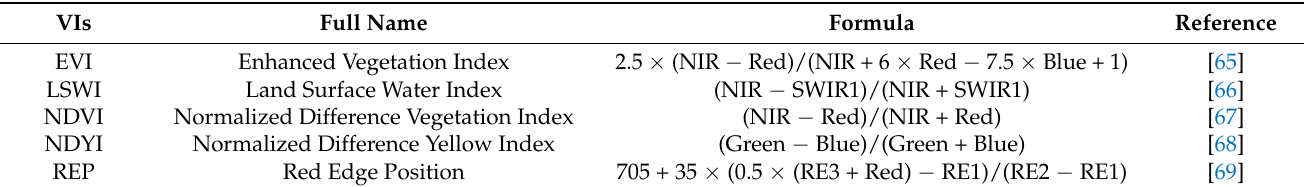
Table 2. The vegetation indices used in this study and the corresponding formula.